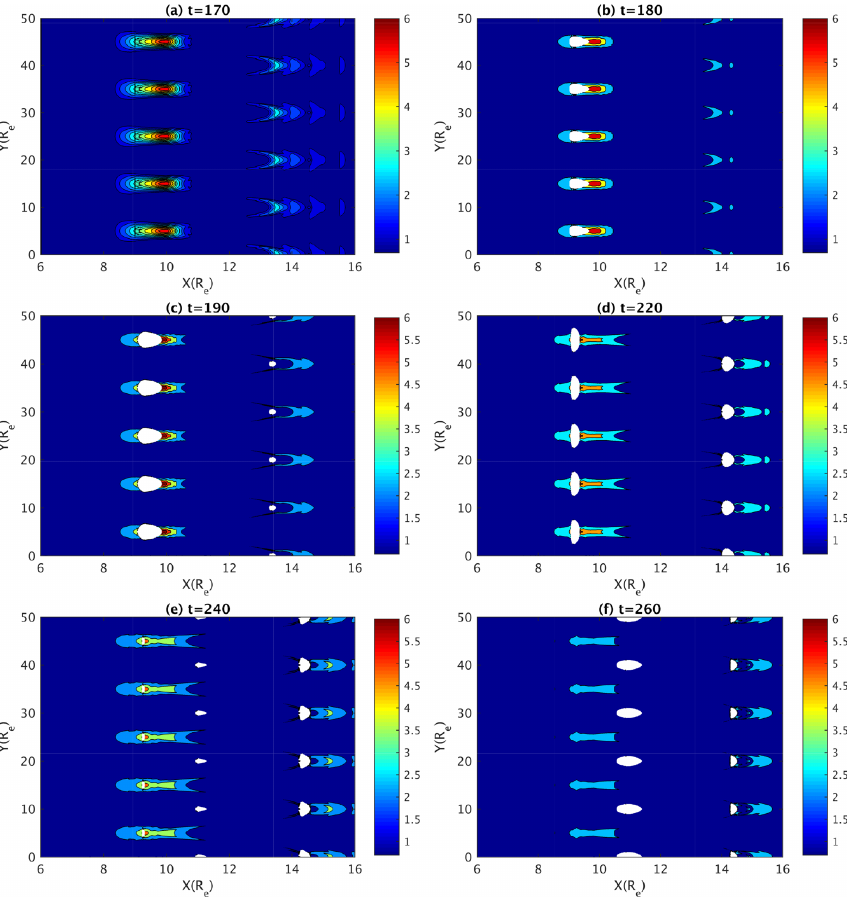
Figure 4. Contours of the logarithm of squashing degree in the z = 0 plane at t = 170 (a) , t = 180 (b) , t = 190 (c) , t = 220 (d) , t = 240 (e) , and t = 260 (f) . White circles denote the locations where the squashing degree becomes